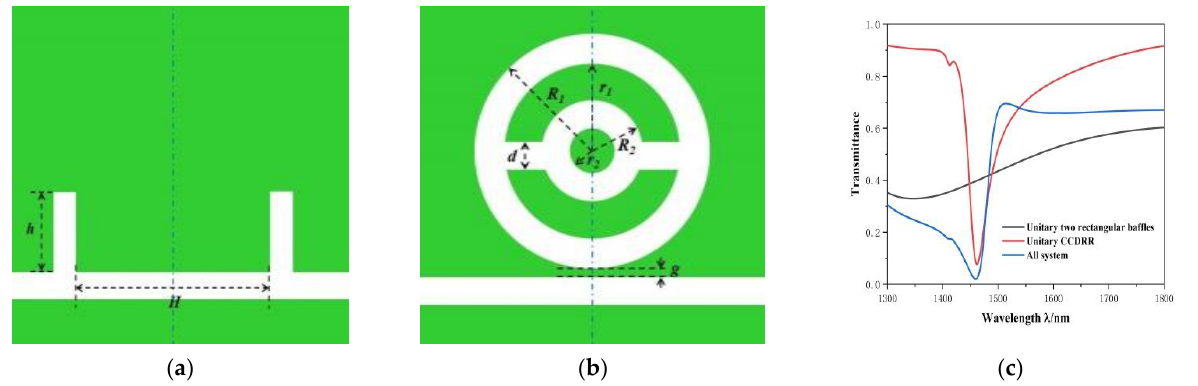
Figure 2. ( a ) Two-dimensional schematic diagram of the unitary two rectangular baffle structure; ( b ) 2D schematic diagram of the unitary CCDRR structure; and ( c ) the transmission spectrum of the unitary two rectangular baffle structure (black line), the unitary CCDRR structure (red line), and the whole system (blue line). To better comprehend the inner theory of the black line’s role in the Fano resonance of the whole structure, the magnetic field distributions and the electric field distributions of the unitary two rectangular baffles and the whole system at the resonance dip point ( λ